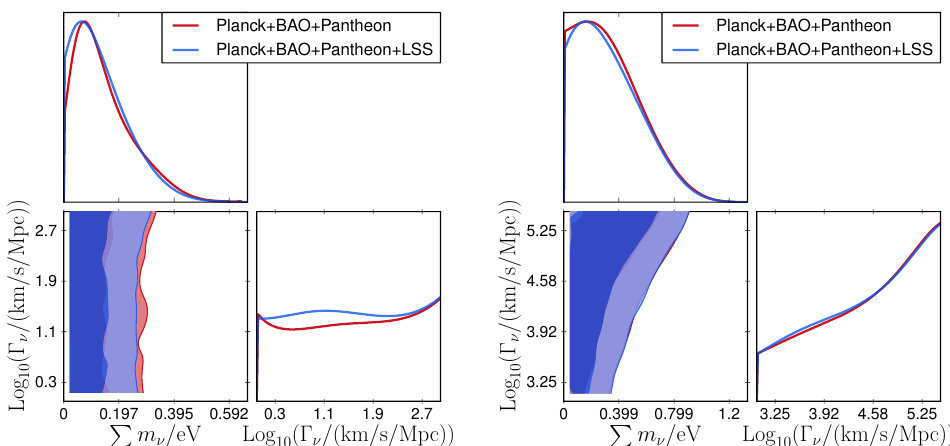
Figure 6 . Posterior distributions of log (cid:0) (cid:23) = (km = s = Mpc) 2 [0 ; 3] are shown in the left panel, while large decay rate log 10 2 [3 ; 5 : 5] are shown in the right